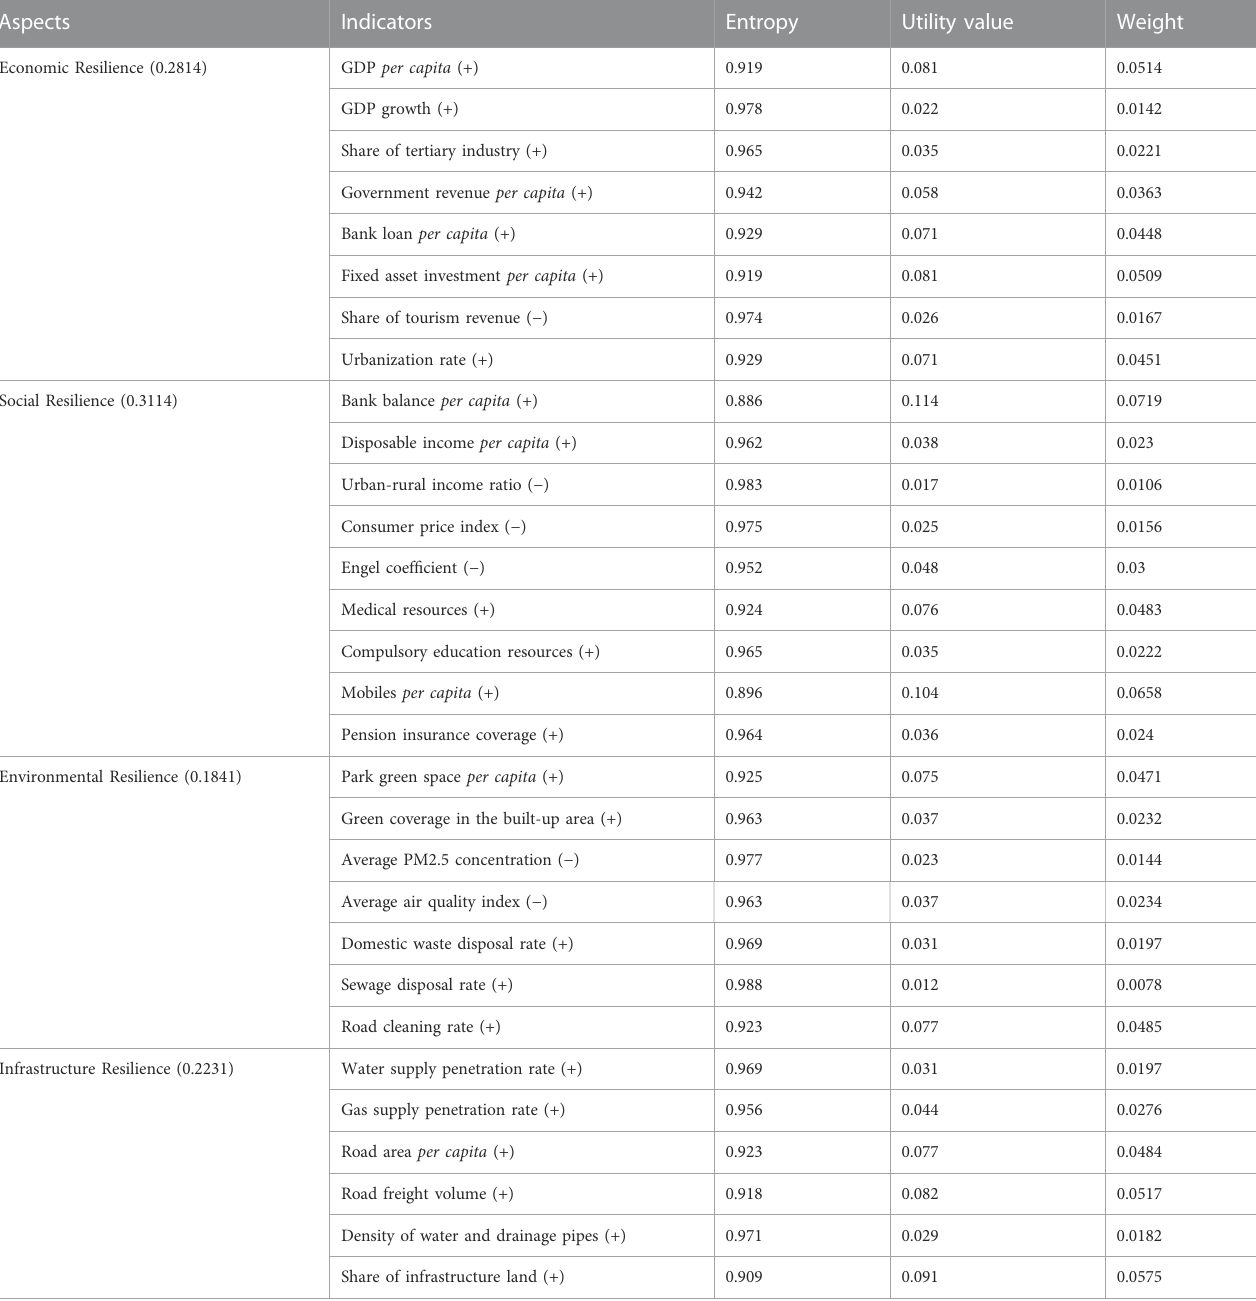
TABLE 1 Evaluation indicators and weights.